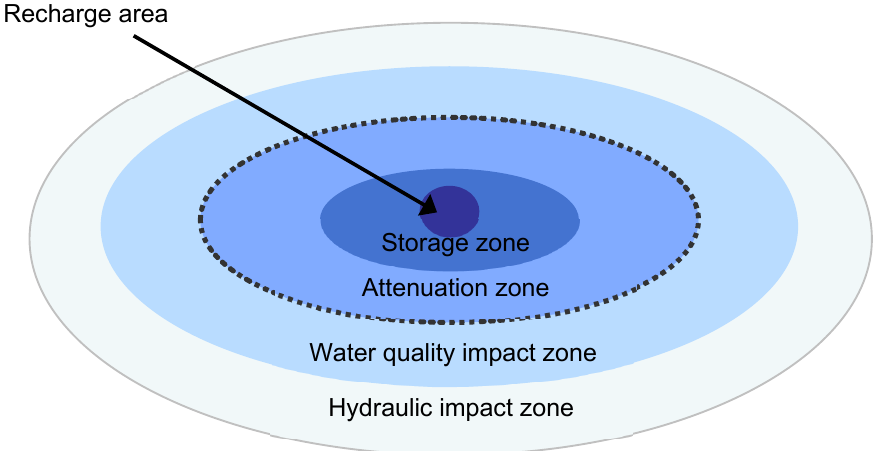
Figure 2. Schematic showing plan view of zones of influence of a managed aquifer recharge (MAR) operation.